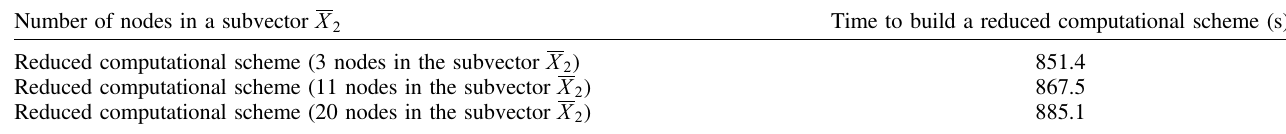
Table 3. Time of building a reduced computational scheme containing a different number of nodes in a subvector X 2 . Number of nodes in a subvector X